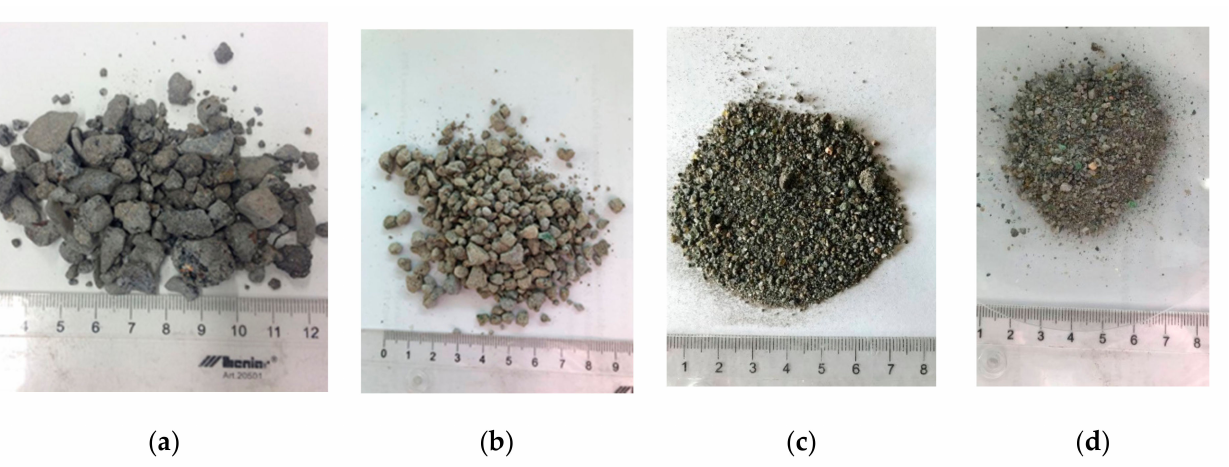
Figure 2. ( a ) Crude MSWIBA–MSWIBA before valorization; ( b ) MSWIBA after valorization; ( c ) 0–2 mm fraction; ( d ) MSWIBA after alkali activation (NaOH pretreatment).